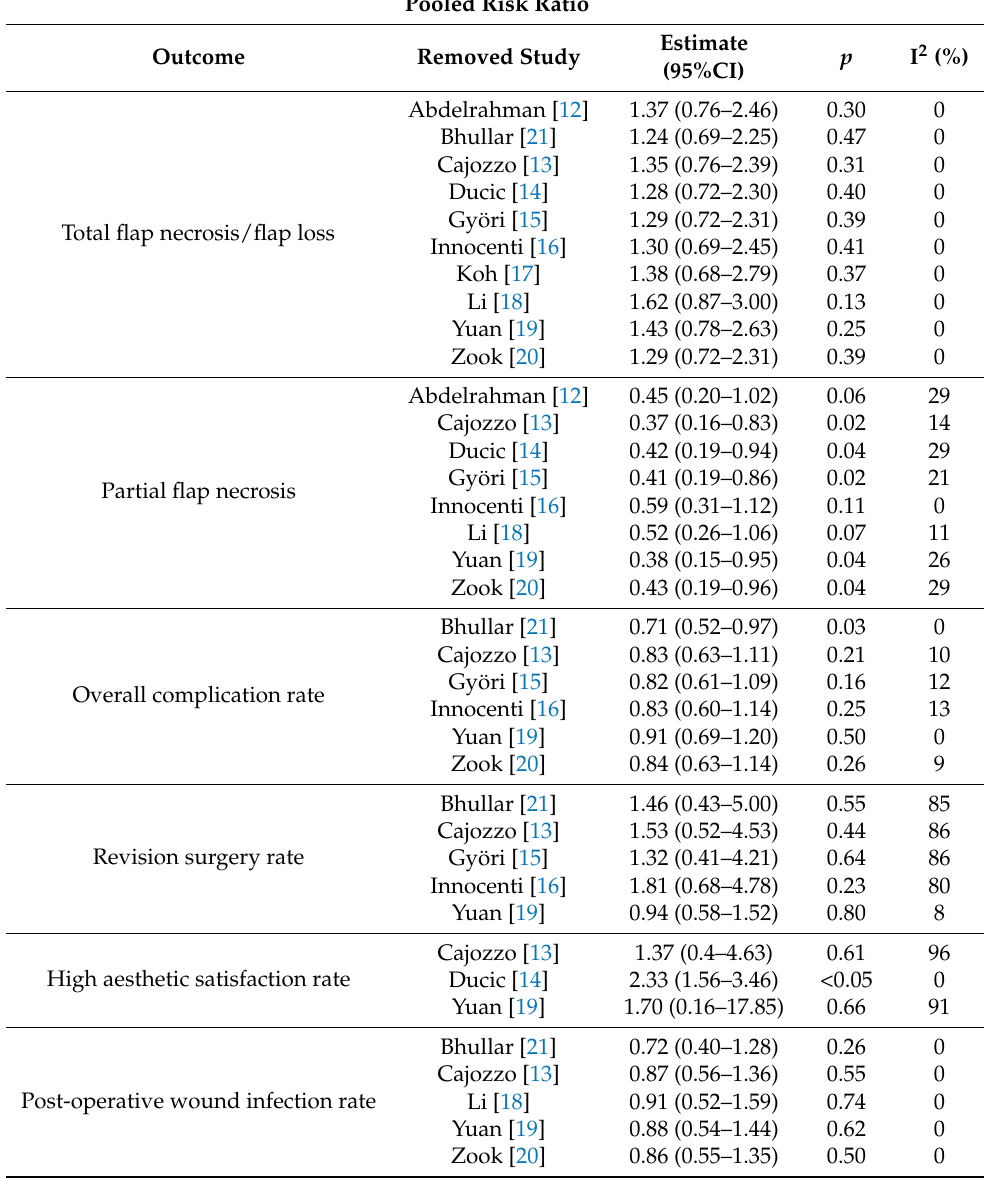
Table 4. Leave-one-out sensitivity